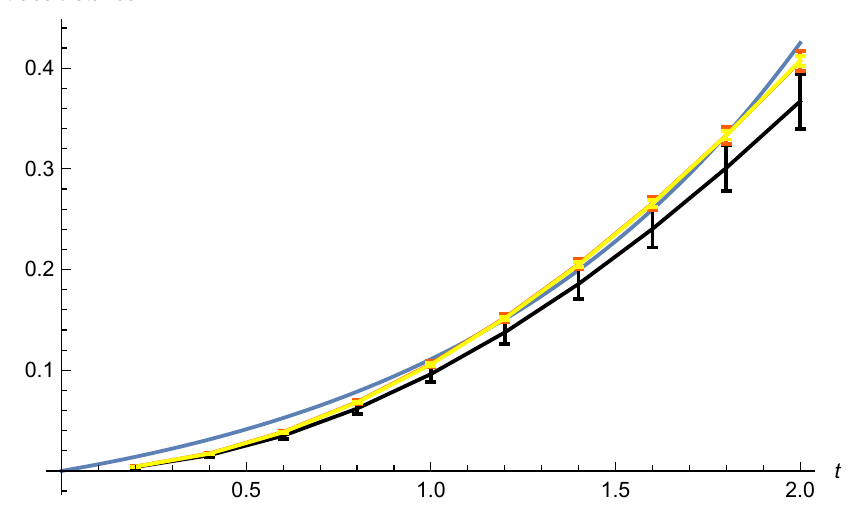
(cid:13) (cid:13) Figure 4 . N is plotted for maximally mixed black hole density matrices, (cid:13) (cid:26) lab ( t ) (cid:0) (cid:26) MF lab ( t ) (cid:13) 1 representing an old black hole. The behavior is very similar to (cid:12)gure